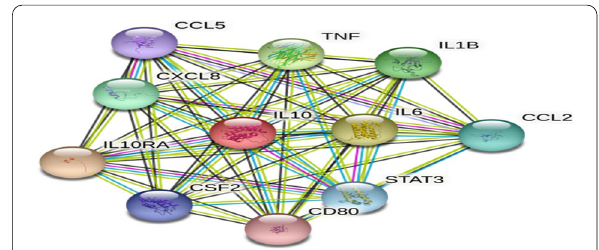
Fig. 5 Protein–protein interaction network of IL-10 protein using STRING